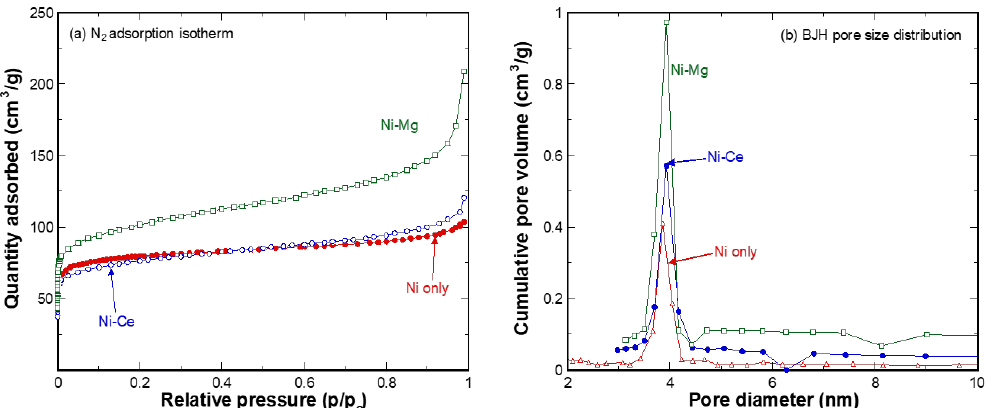
Figure 5. Pore structure analysis of Ni/Eco, Ni-Ce/Eco, and Ni-Mg/Eco catalyst. ( a ) N 2 adsorption isotherm and ( b ) BJH pore size distribution.